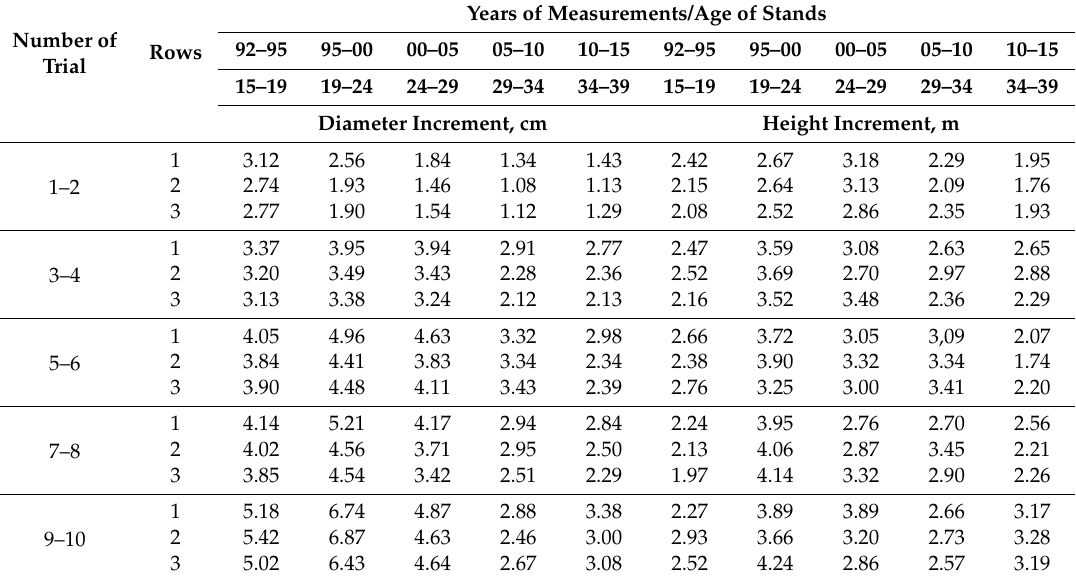
Table 2. Increment of trees growing in the bordering to strip road (1), in the second (2) and in the third (3) rows to strip